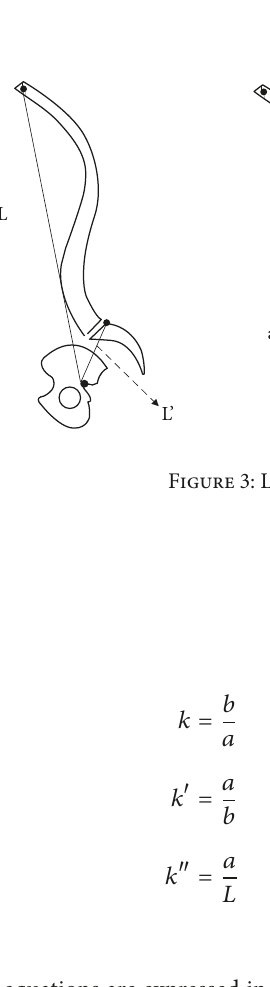
Figure 2: Diagram of the sagittal view of the spinopelvic system showing landmark points used to measure angles and distances used in the predictive equations (a). The location of these points was identified and measured in an actual full sagittal spine X-ray (b).